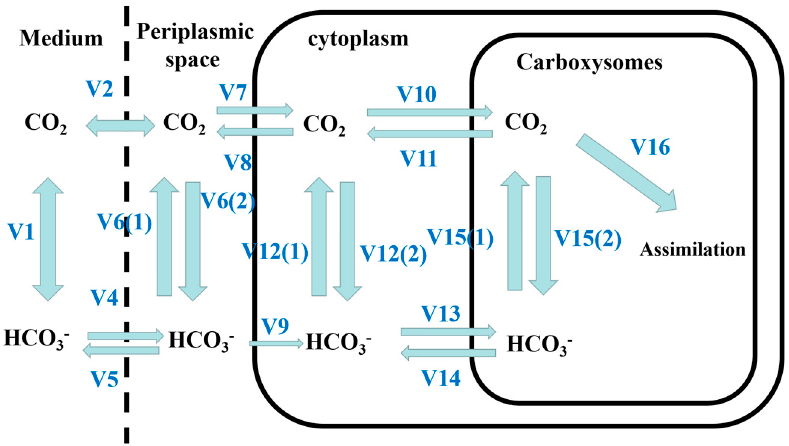
Figure 1. Fridlyand calculation